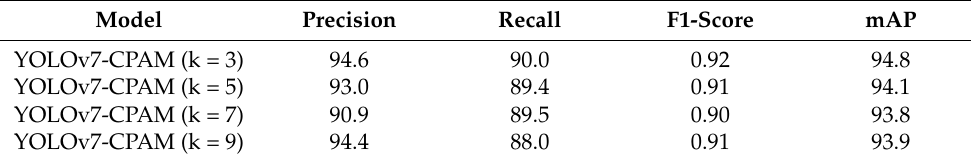
Table 6. The results of CPAM with different convolution kernel sizes.